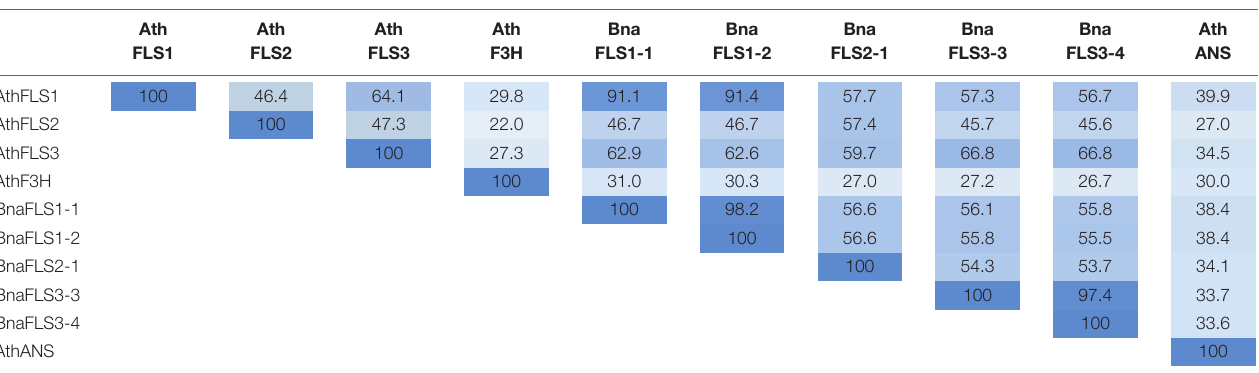
FIGURE 3 | Genomic structure of BnaFLS candidates expressed in seeds. The exon-intron structure of BnaFLS candidates is shown. The exons are split into coding sequences (CDS, black) and untranslated regions (UTR, gray) and are displayed by rectangles, introns are displayed as black connecting lines. TABLE 3 | Sequence identity of BnaFLS candidates and 2-ODD members of A. thaliana